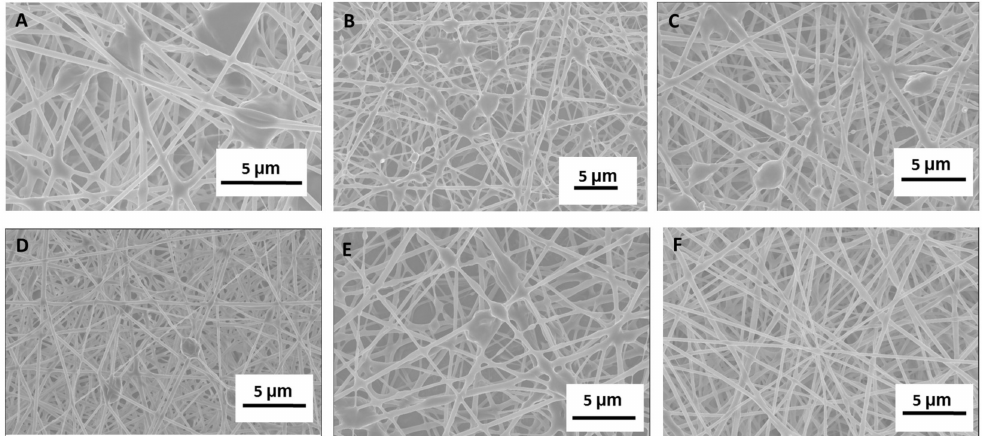
Figure 2. Optimization of core/shell electrospinning. Configurations investigated were: core flow rate ( µ L/min)/shell flow rate ( µ L/min)/voltage (kV)/distance (cm). SEM images of nanofibers formed under specific conditions: ( A ) 9/1.5/13/15, ( B ) 4.5/1.5/11/15, ( C ) 4/2/11/15, ( D ) 3/3/12.5/15, ( E ) 2.25/0.75/11/15, ( F ) 1.5/1.5/11/15. Configuration ( F ) showed uniform fiber mats that were comparable to PLGA fiber mats and was used throughout. Scale, 5 µ m.